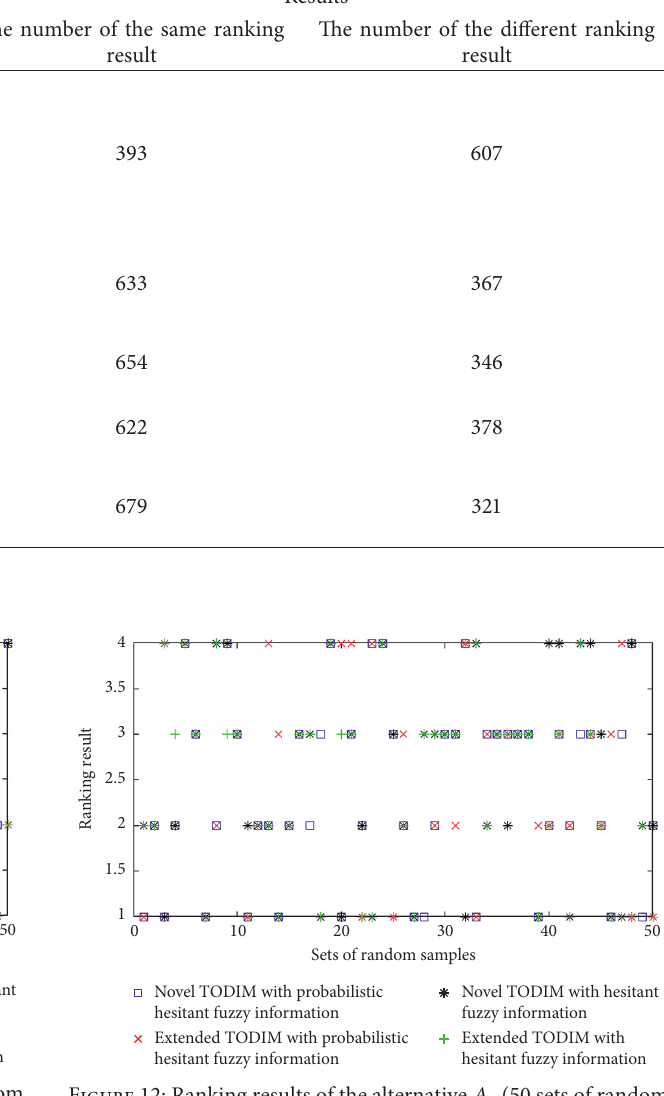
(50 sets of random 3